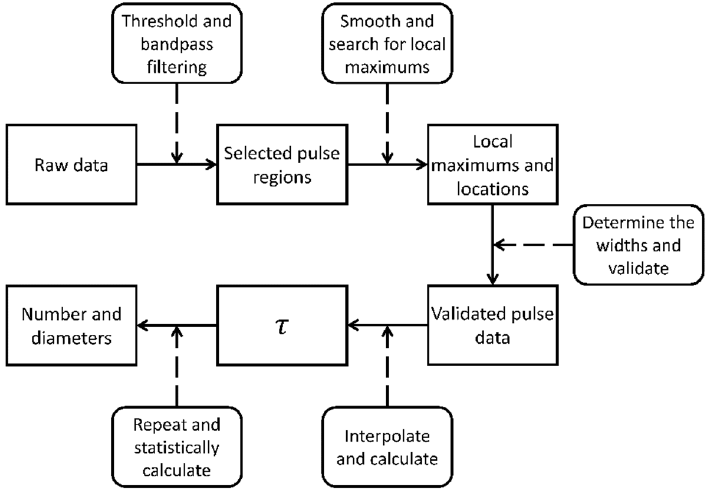
Figure 6. Diagram of data analysis.